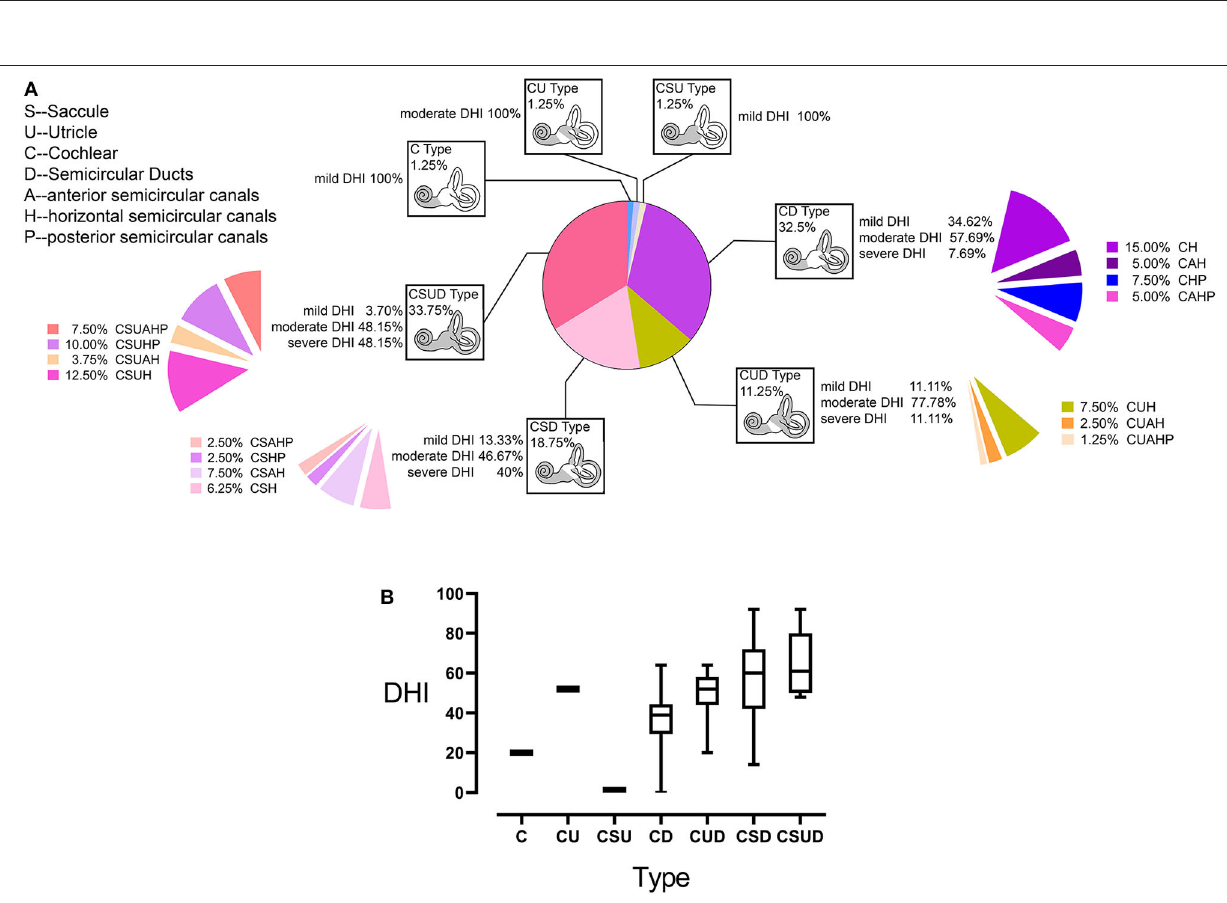
Frontiers in Neurology |